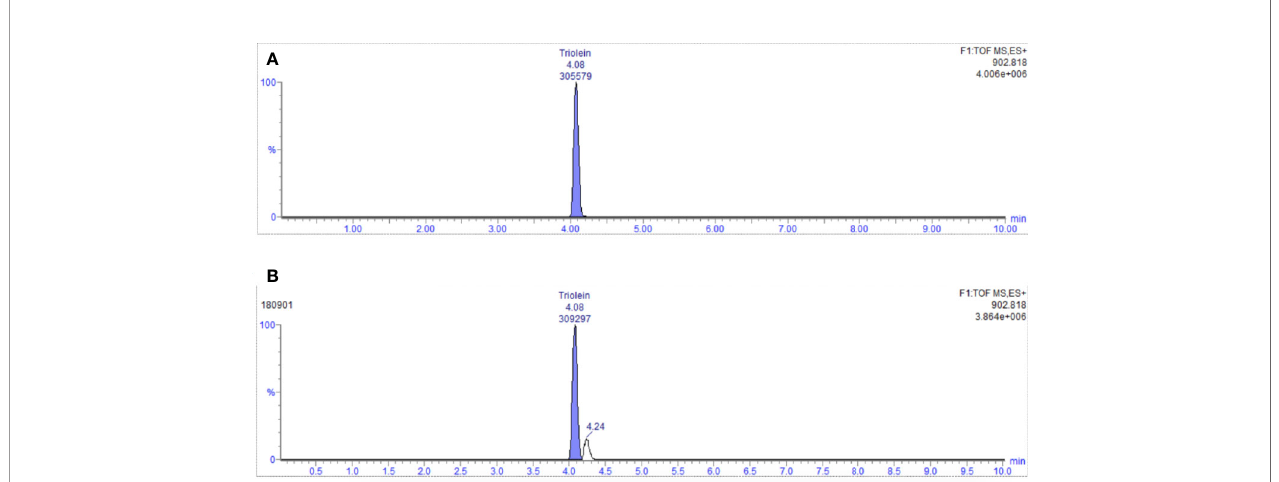
FIGURE 7 | (A) Chromatogram of reference (glycerol trioleate); (B) EIC diagram of representative sample (No.